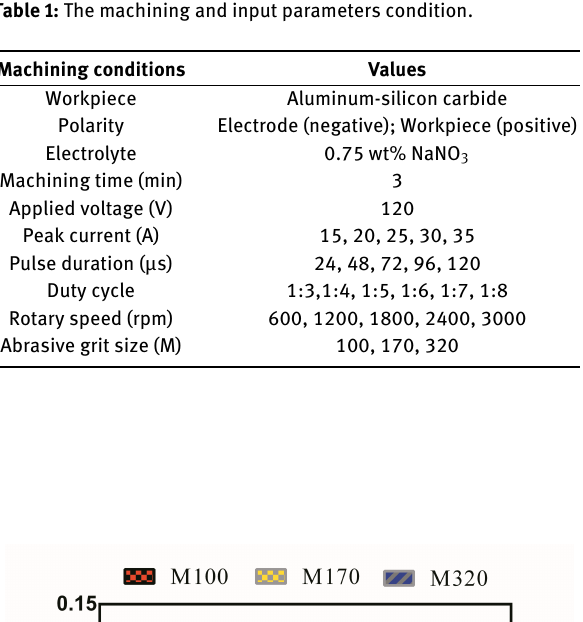
Table 1: The machining and input parameters condition.